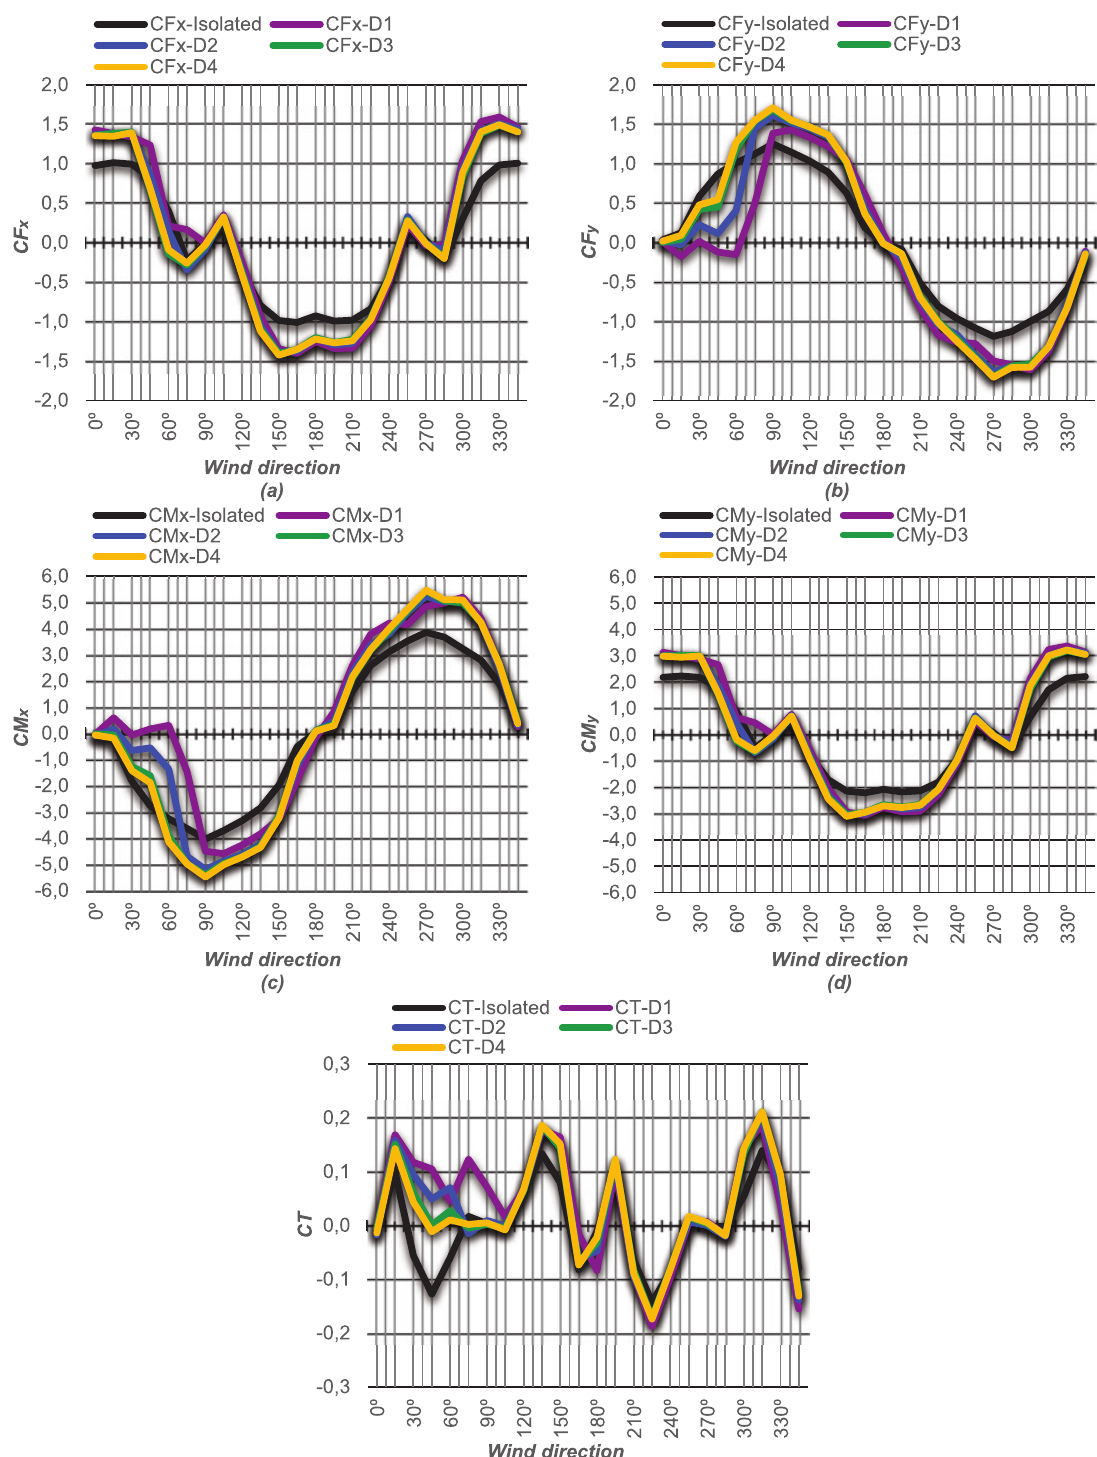
Figure 10 Load coefficients for the vicinity V3: (a) Resultant force in the direction of the X axis; (b) Resultant force in the direction of the Y axis; (c) Base momenta round axis X; (d) Base moment around axis Y; (e) Torsion around building